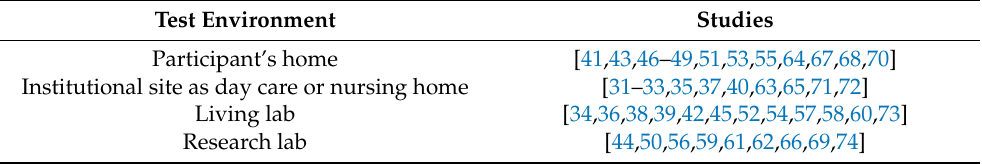
Table 8. Environments where the usability evaluations were